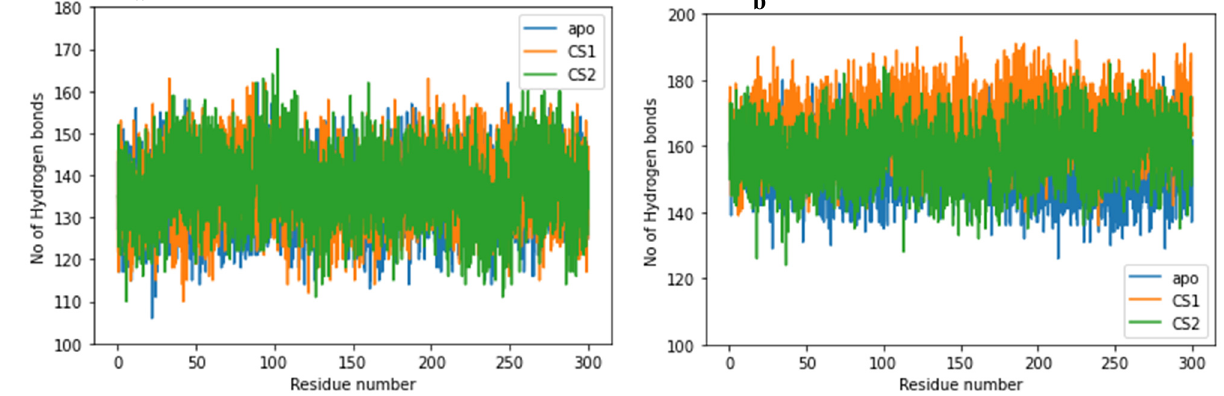
Figure 7. Hydrogen bond formation plot for ( a ) apo-3CLpro protease (blue) and complexes of 3CLpro with CS1 (orange) and CS2 (green) during the 600 ns MD simulation time. ( b ) apo-PLpro protease (blue) and complexes of PLpro with CS1 (orange) and CS2 (green) during the 600 ns MD simulation time. Table 4. Hydrogen bonds between the complexes of 3CLpro/PLpro with CS1 and CS2 over the simulation